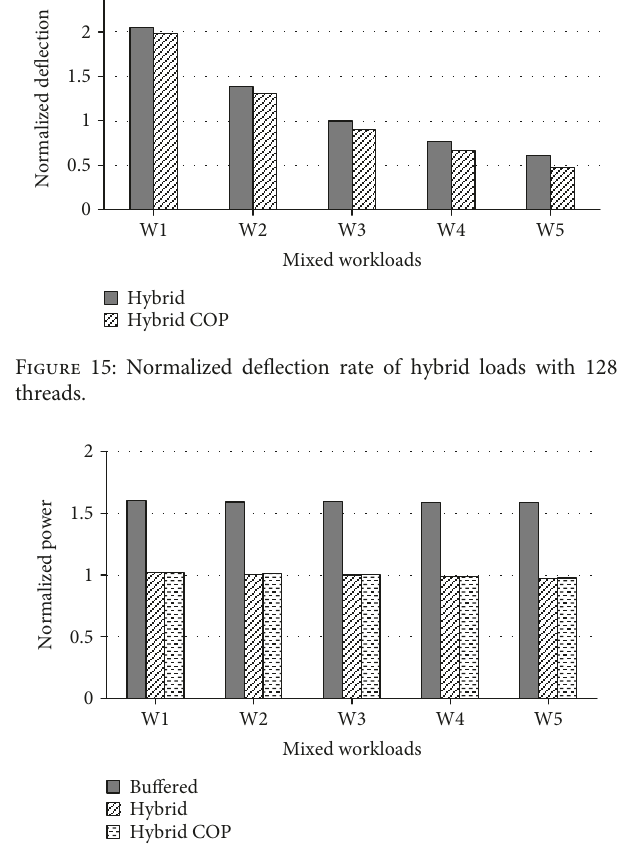
Figure 16: Normalized energy of hybrid loads with 128 threads.